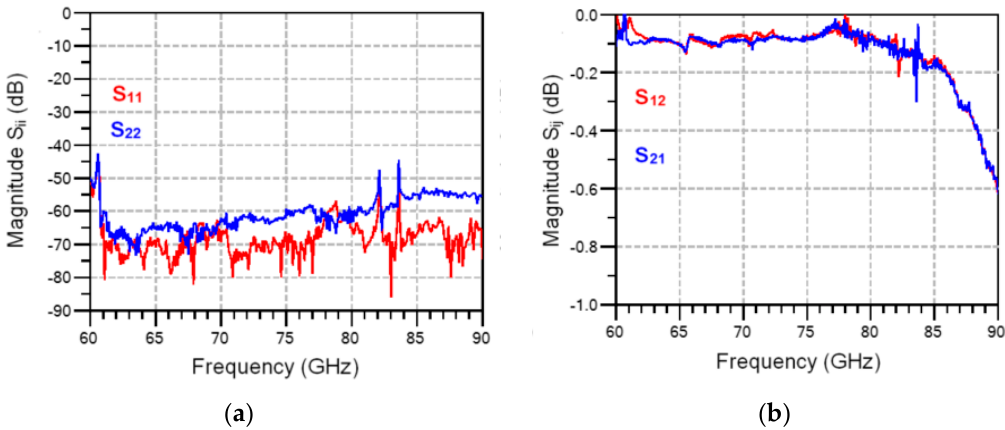
Figure 27. Initial calibration results on line (L): ( a ) matching; ( b ) insertion loss.